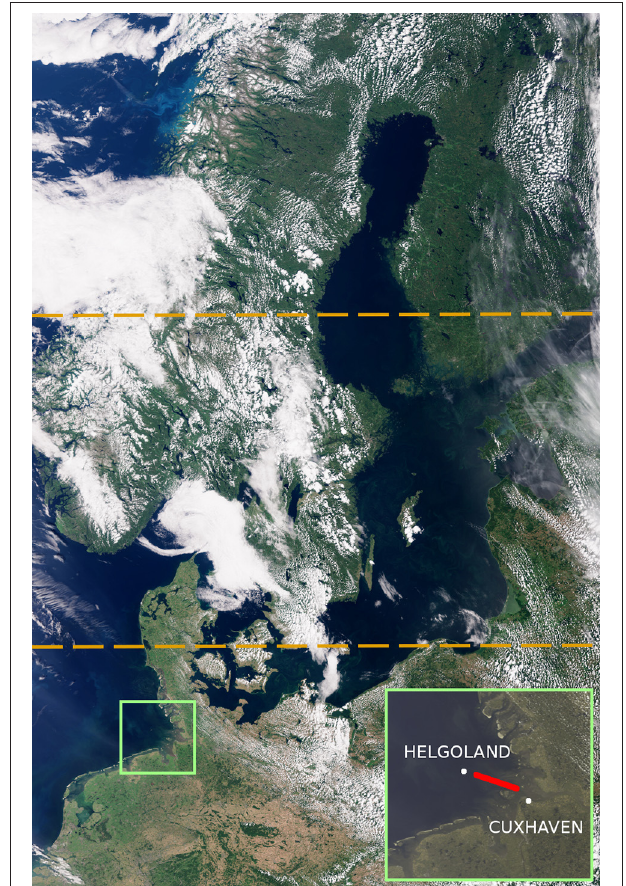
FIGURE 5 | Sentinel-3 OLCI (top-of-atmosphere) scene of 20 July 2016 (contains modified Copernicus Sentinel data [2016] processed by ESA/EUMETSAT/HZG). The boundaries of individual scenes are marked with dashed lines. The picture detail shows the route with reflectance measurements in the German